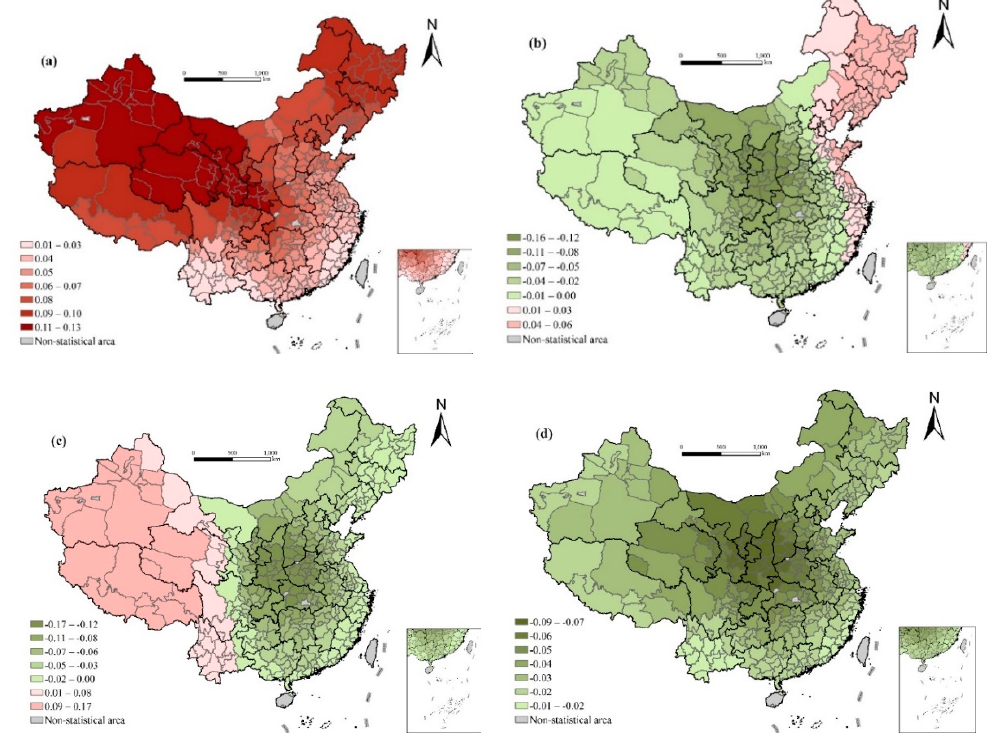
Figure 8. Spatial variation of regression outputs from the GWR model: ( a ) urban population size (ln); ( b ) prefecture-level cities; ( c ) sub-provincial cities and provincial capitals; and ( d ) province-level cities.